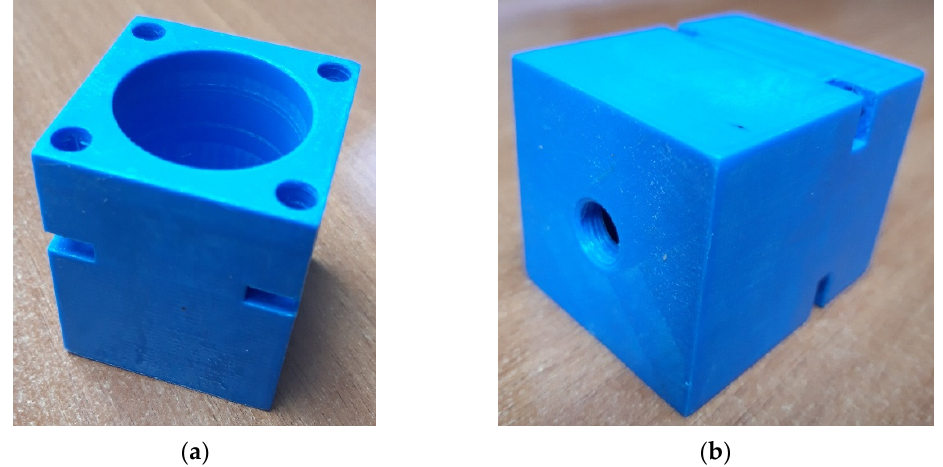
Figure 1. ( a ) Front side of the cylinder; ( b ) Backside of the cylinder with a hole with thread for the pneumatic hose con- nection.